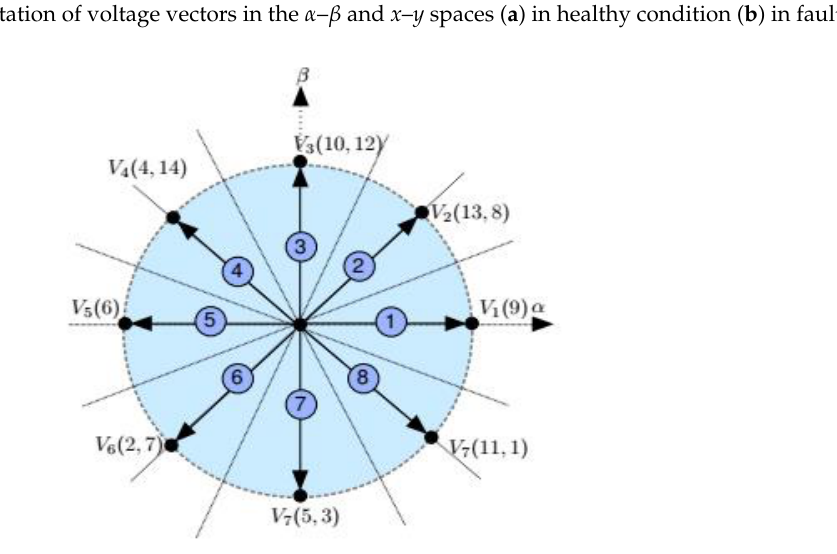
Figure 6. Implemented virtual voltages in the α – β plane using the designed post-fault DTC approach. 432